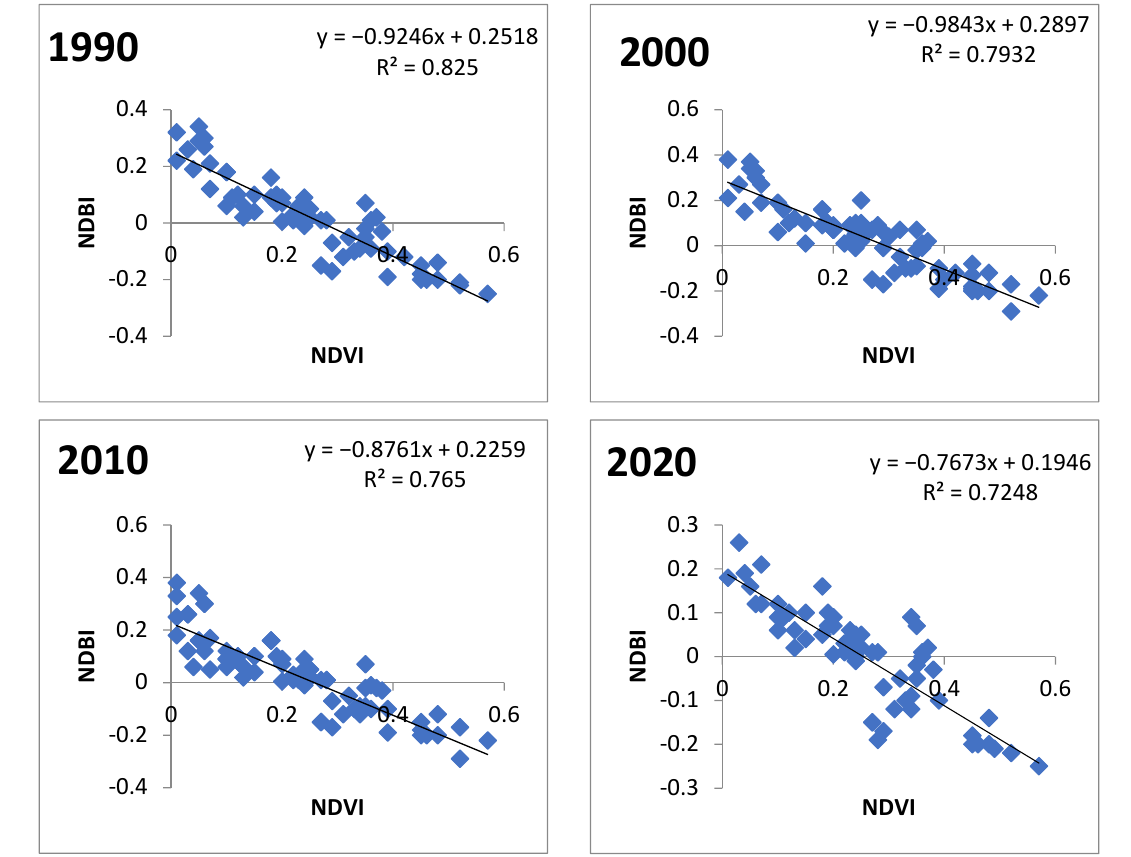
Figure 9. Regression analyses concerning NDBI and NDVI in the study district.